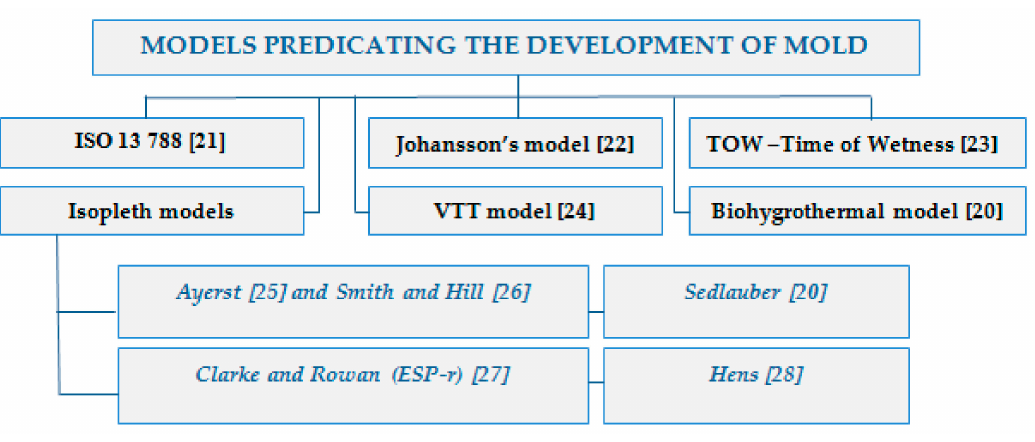
Figure 1. Models of mold